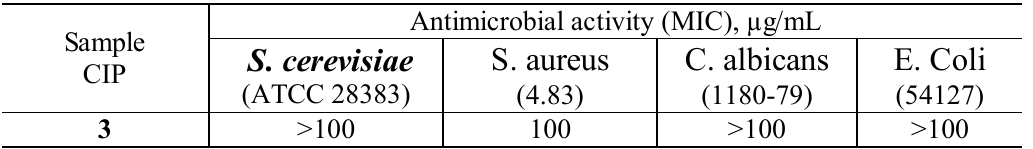
Table 2: Antimicrobial activity of Schiff base